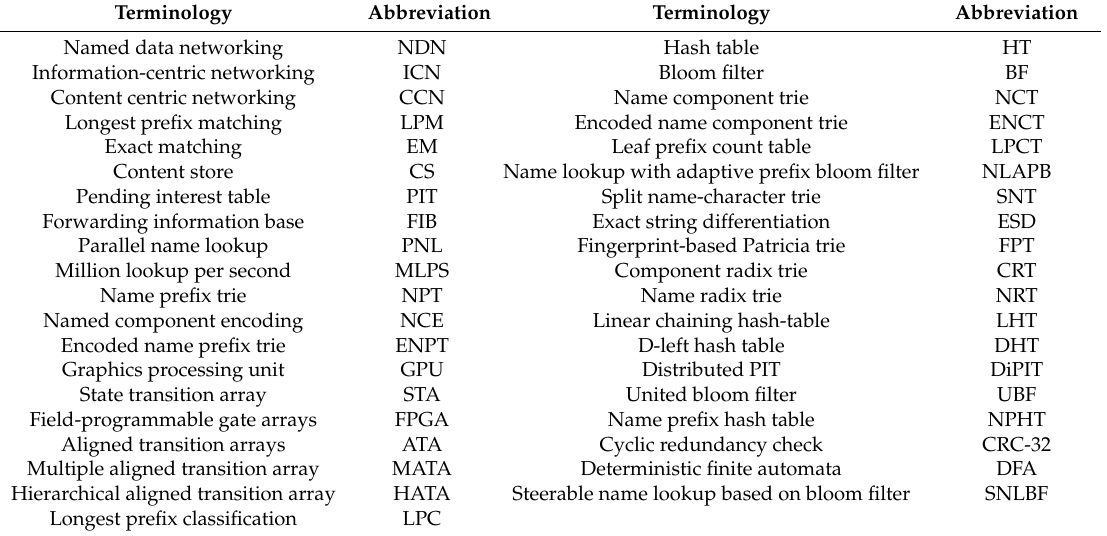
Table 2. Abbreviations of the review’s